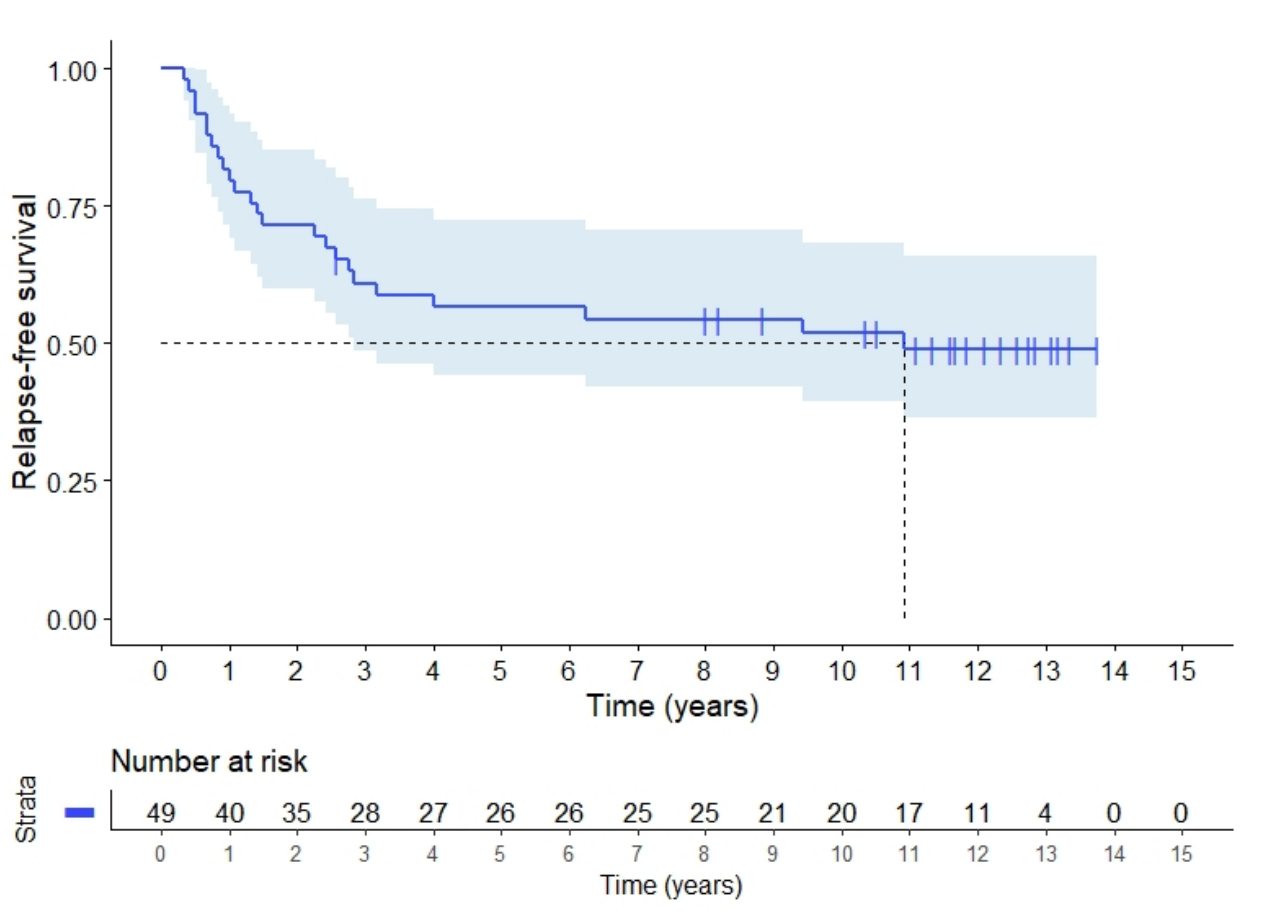
Figure 2. Relapse-free survival (RFS) for 49 rectal cancer patients with locally advanced or recurrent rectal adenocarcinoma.